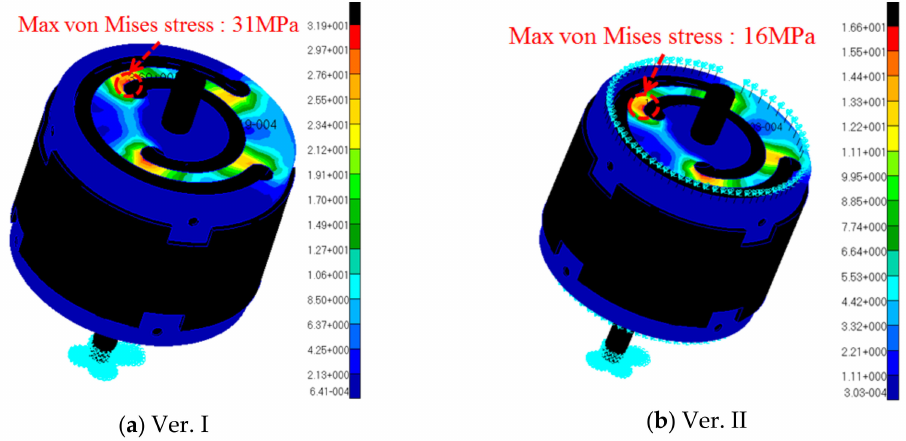
Figure 8. Stress contour of VEH via static FE analysis.